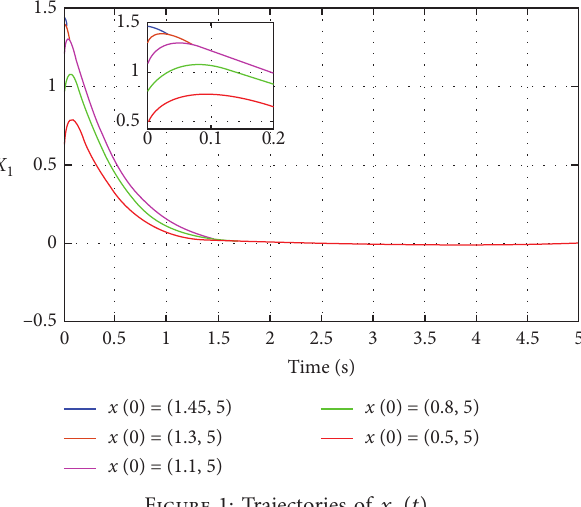
Figure 1: Trajectories of x